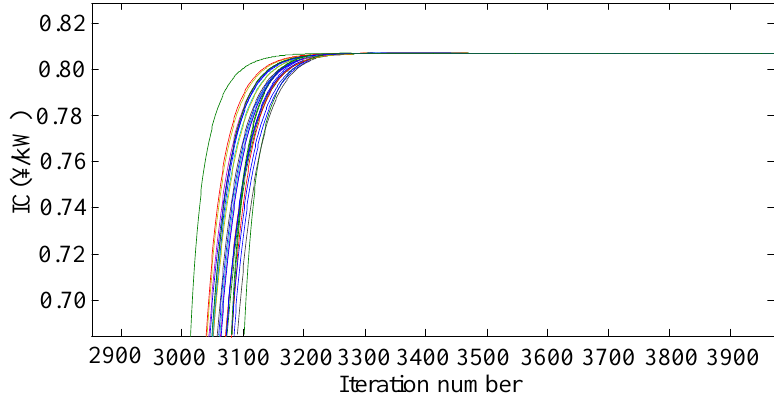
Figure 16. The IC of each customer of the 32 customers’ system.